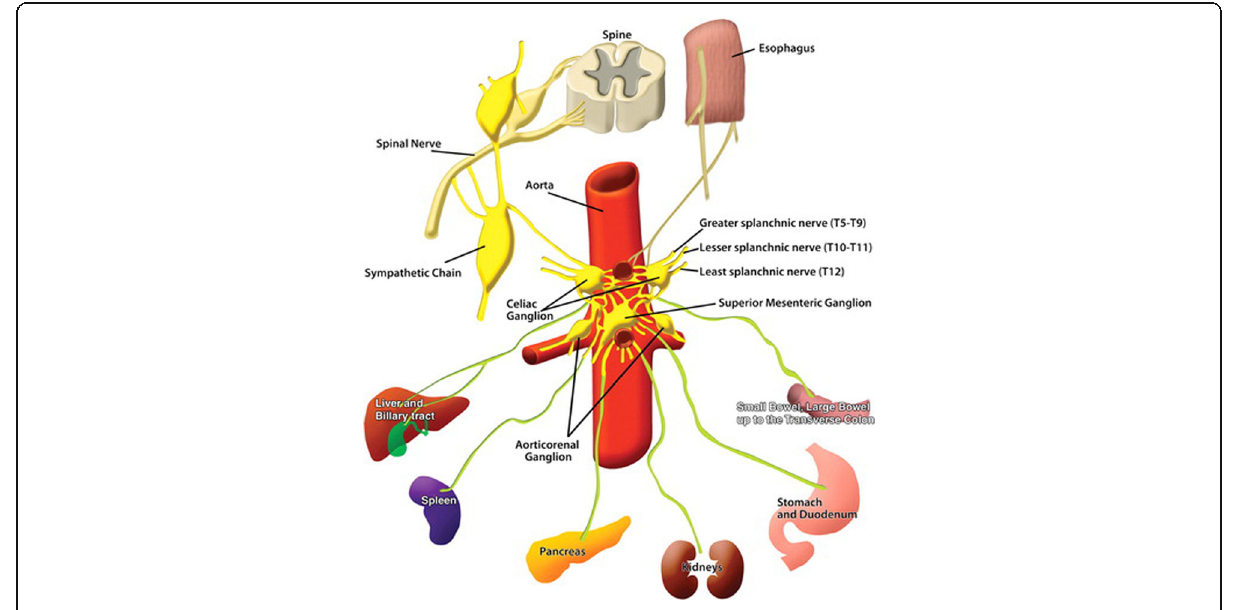
Fig. 4 Schematic diagram showing the celiac plexus anatomy